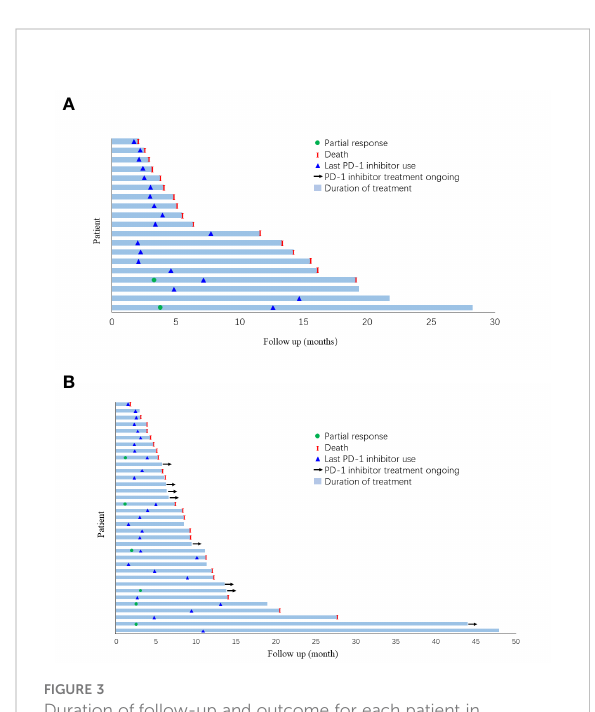
FIGURE 3 Duration of follow-up and outcome for each patient in (A) monotherapy group and; (B) combination